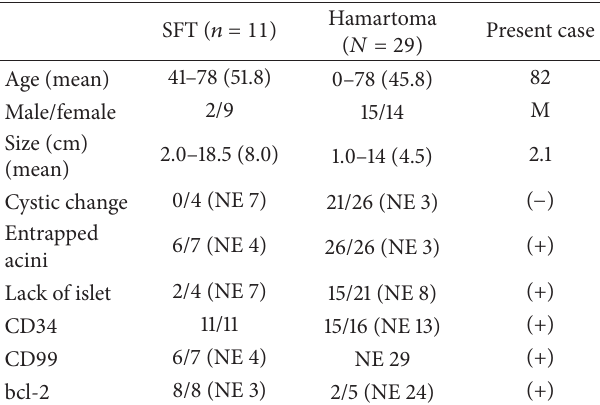
Table 1: Clinicopathological comparison between solitary fibrous tumors and pancreatic